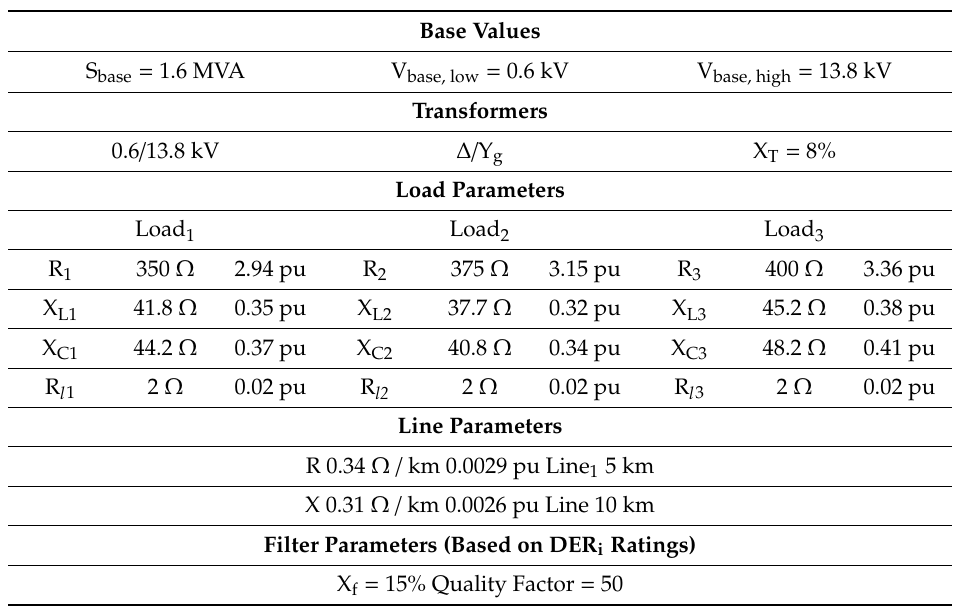
Figure 1. Case-study system ( a ) The studied microgrid (MG) and ( b ) power management system (PMS) and non-droop control system. Table 1. Parameters of the microgrid.